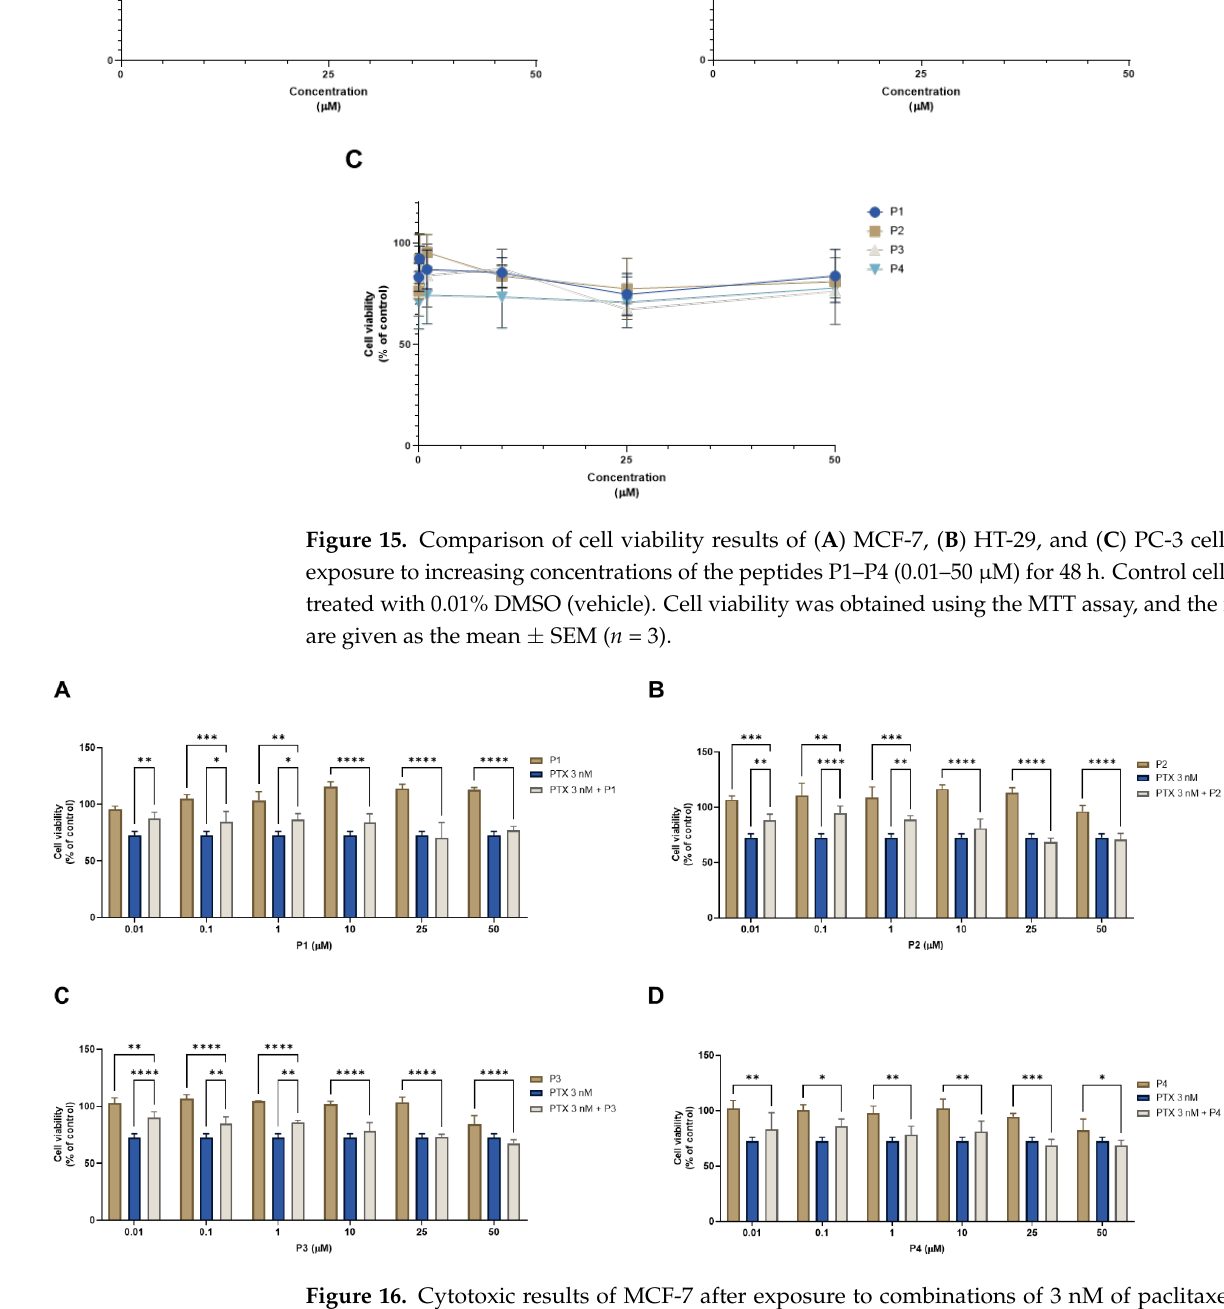
Table 3. IC 50 values of the antineoplastic agents PTX, 5-FU, and DOXO obtained from the literature and used in this study for combination treatments.